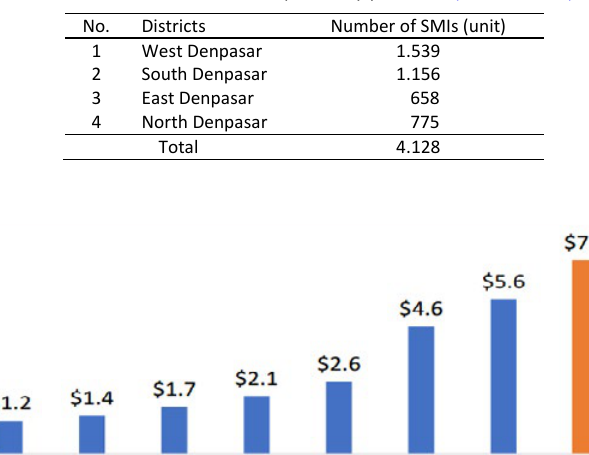
Table 1: Number of SMIs in Denpasar City year 2016 (DBICDY, 2016) Table 1. Number of SMIs in Denpasar City year 2016 (DBICDY, 2016)